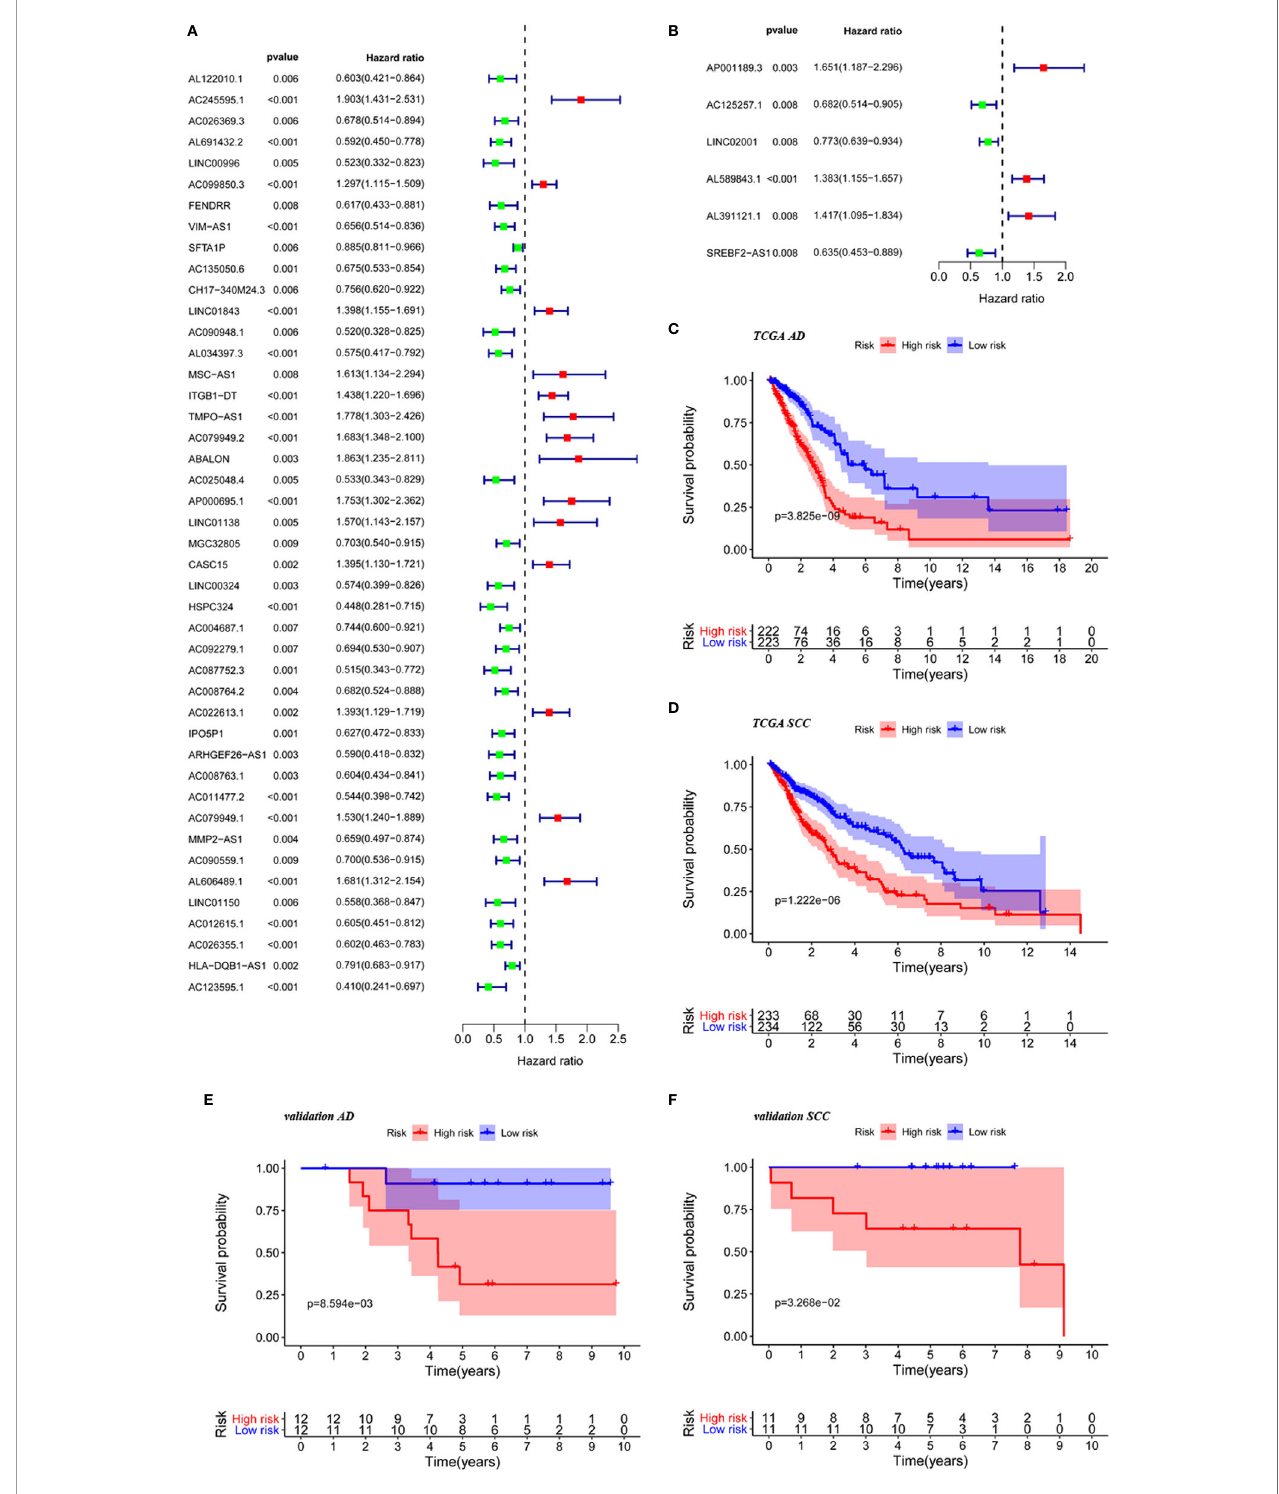
FIGURE 1 | The construction of risk score based on signi fi cant lncRNAs. Immune-related lncRNAs selected by univariate Cox analysis for TCGA AD patients (A) and TCGA SCC patients (B) . KM curve for TCGA AD patients (C) , TCGA SCC patients (D) , AD patients from validation cohorts (E) and SCC patients from validation cohort (F) in low-risk group and high group based on the risk